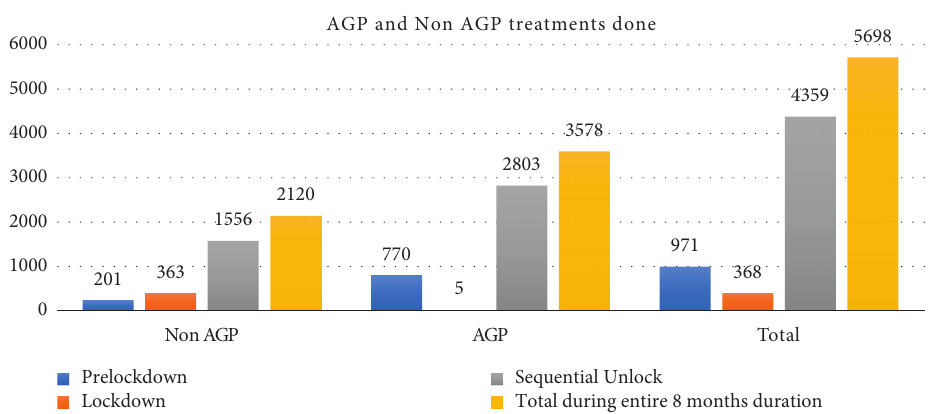
Figure 3: Total number of AGPs and non-AGPs done and comparing them among various time periods and to the